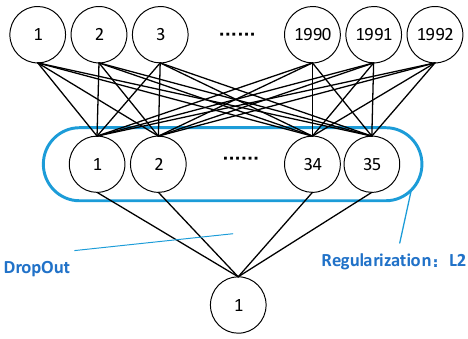
Figure 10. Fully connected neural network.